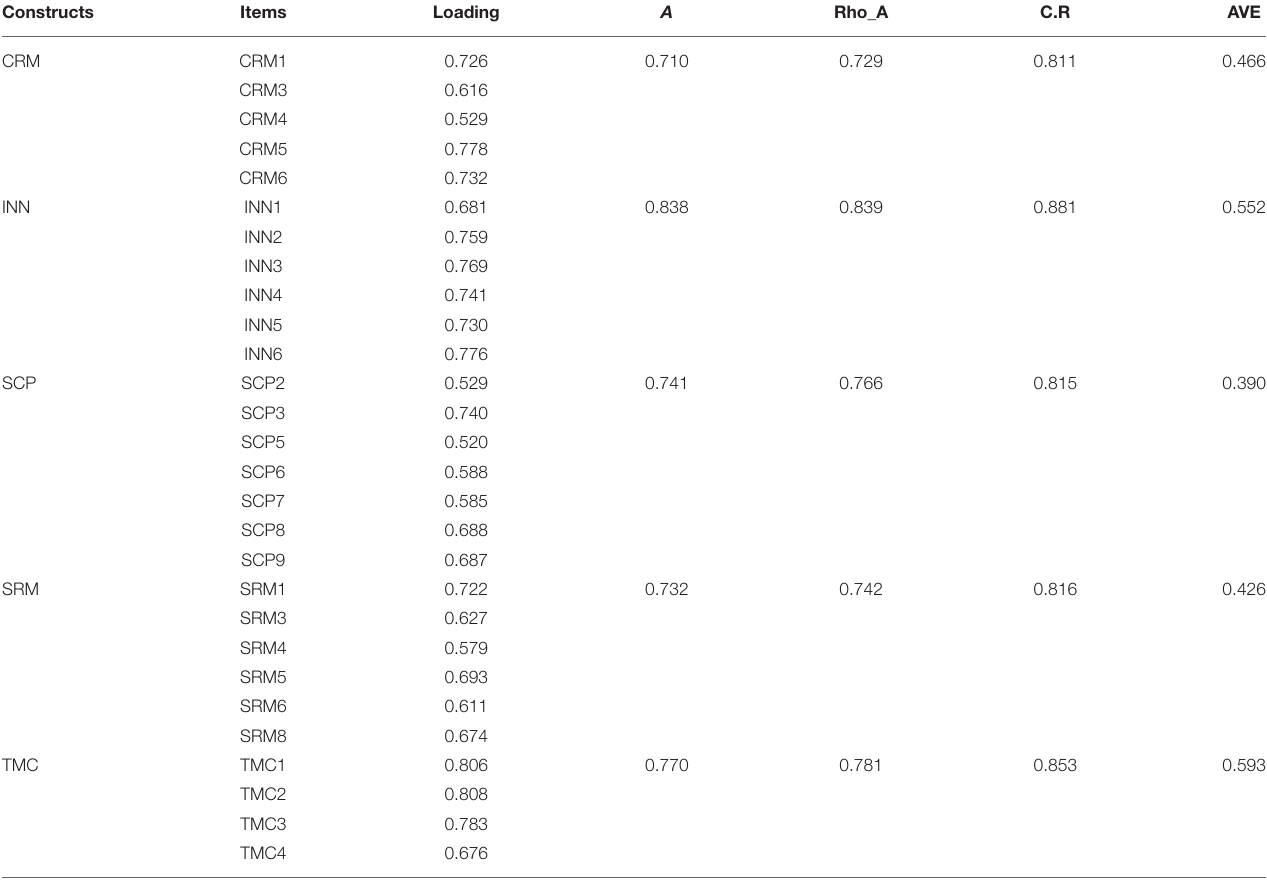
TABLE 4 | Construct reliability, validity, factor, and cross loadings ( N = 208). Constructs